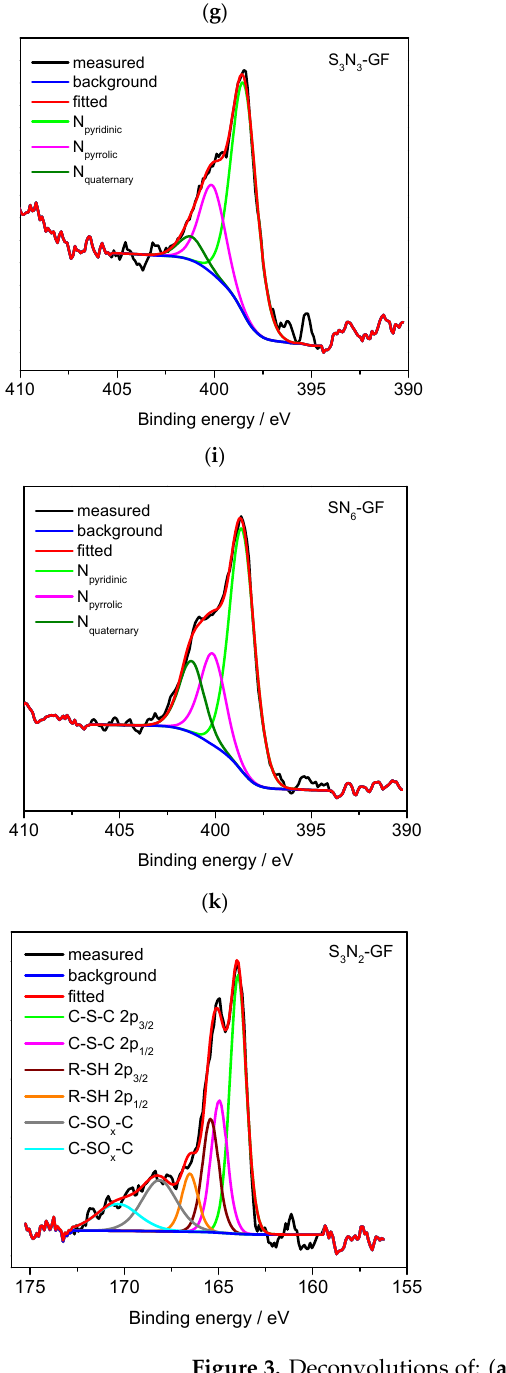
Figure 3. Deconvolutions of: ( a – c ) C1s photoionization; ( d – f ) O1s photoionization; ( g – i ) N1s pho- toionization; ( j – l ) S2p photoionization.